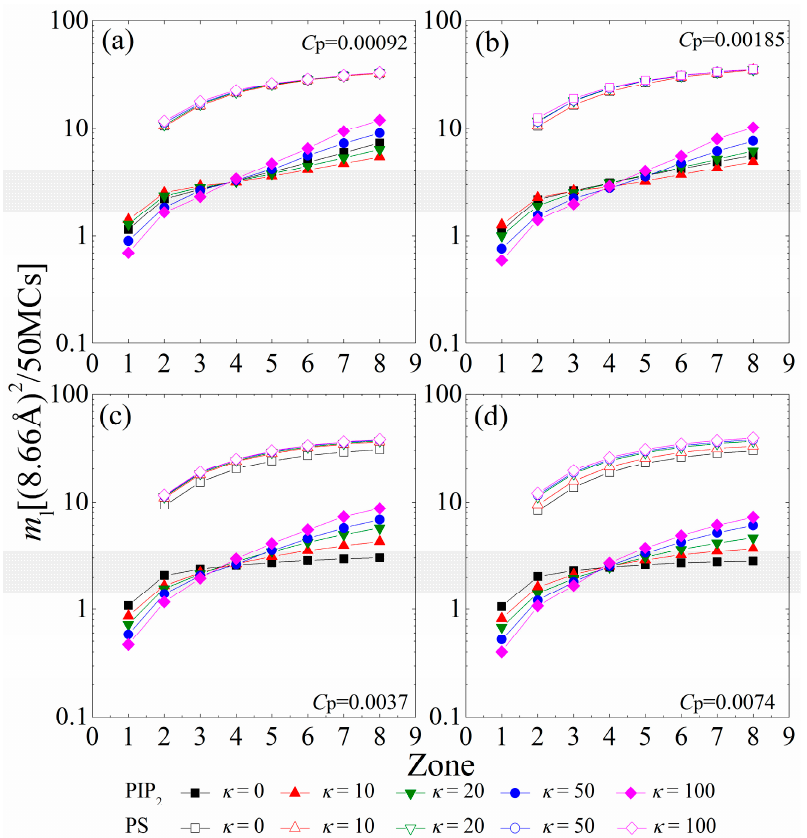
Figure 7. MSD of single PIP 2 ( m l-PIP2 , solid symbols and solid lines) and single PS ( m l-PS , vacant symbols and solid lines) sequestered in each interaction zone calculated in every 50 MC steps for various chain rigidity parameters κ for ( a ) C p = 0.00092; ( b ) C p = 0.00185; ( c ) C p = 0.0037; and ( d ) C p = 0.0074. The results shown are for PC:PS:PIP 2 = 98:1:1. For higher polymer concentrations (e.g., C p = 0.0037 and C p = 0.0074, shown in Figure 7c,d), the